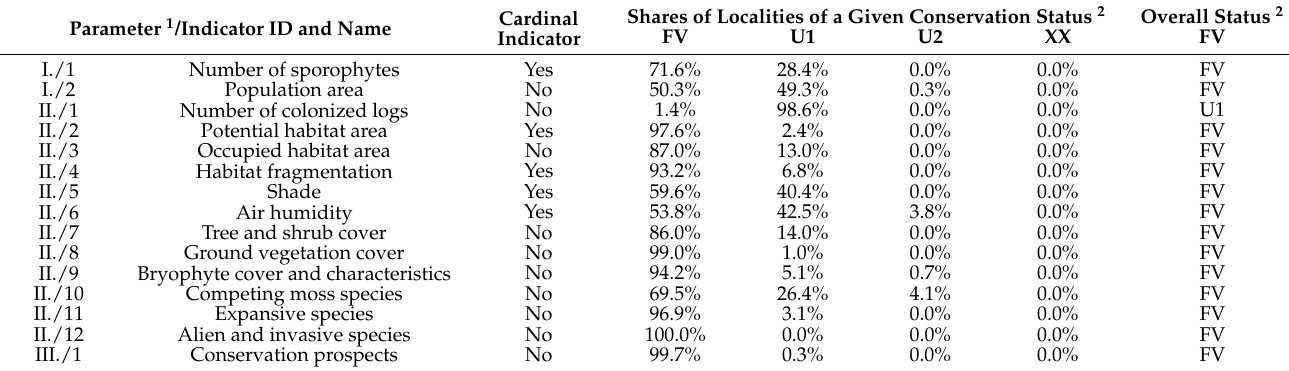
Table 3. Evaluation of Buxbaumia viridis conservation in the Natura 2000 site Bieszczady PLC180001. Parameter 1 /Indicator ID and Name